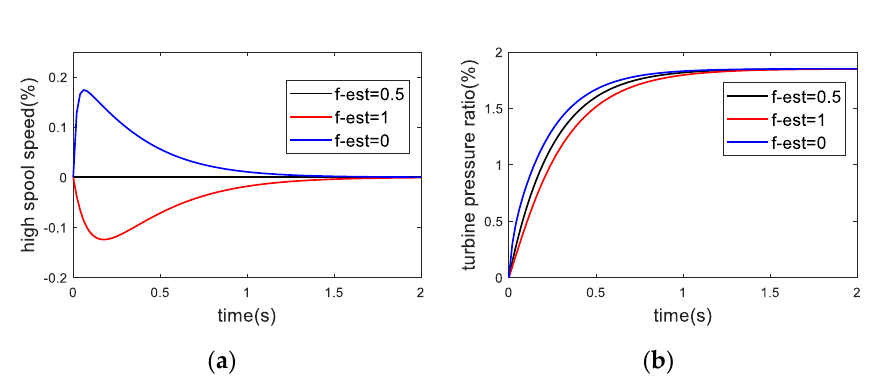
Figure 10. FTC result in different fault reconstruction (FC) situations. ( a ) controlled variables ( b ) control variables.